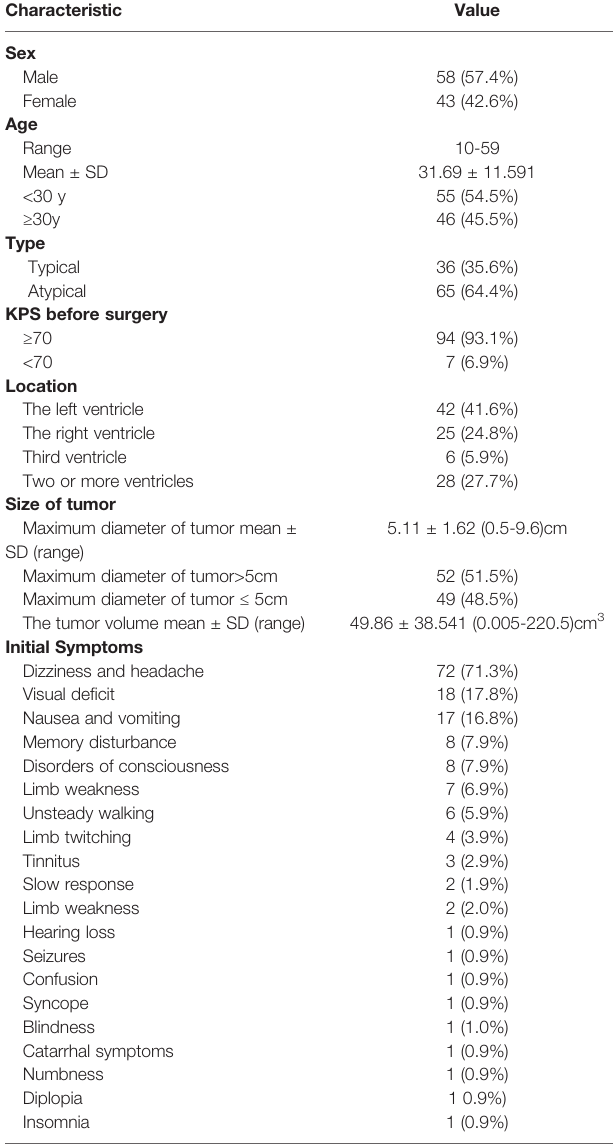
TABLE 1 | Characteristics for patients with CNs.